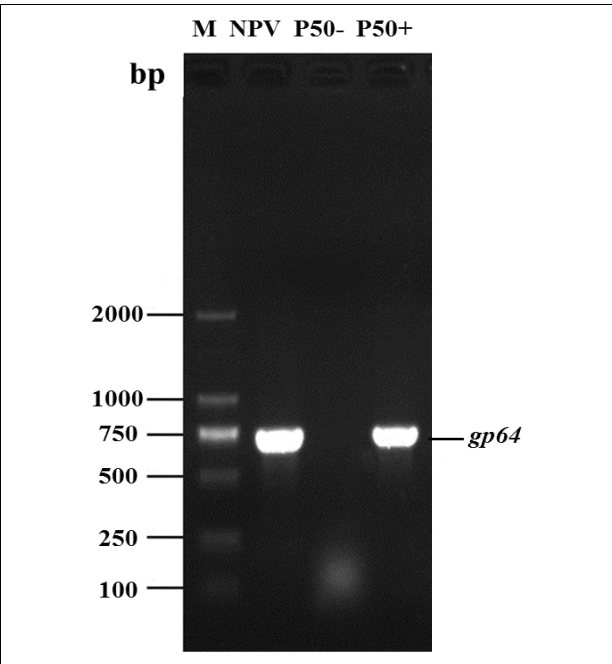
FIGURE 1 | P50 silkworm strains BmNPV free (P50-) and infected (P50+). The DNA of the silkworm midgut was used as a template for baculovirus major protein gp64 gene PCR amplification. BmNPV DNA was used as a positive control (NPV). M, DNA molecular weight marker.